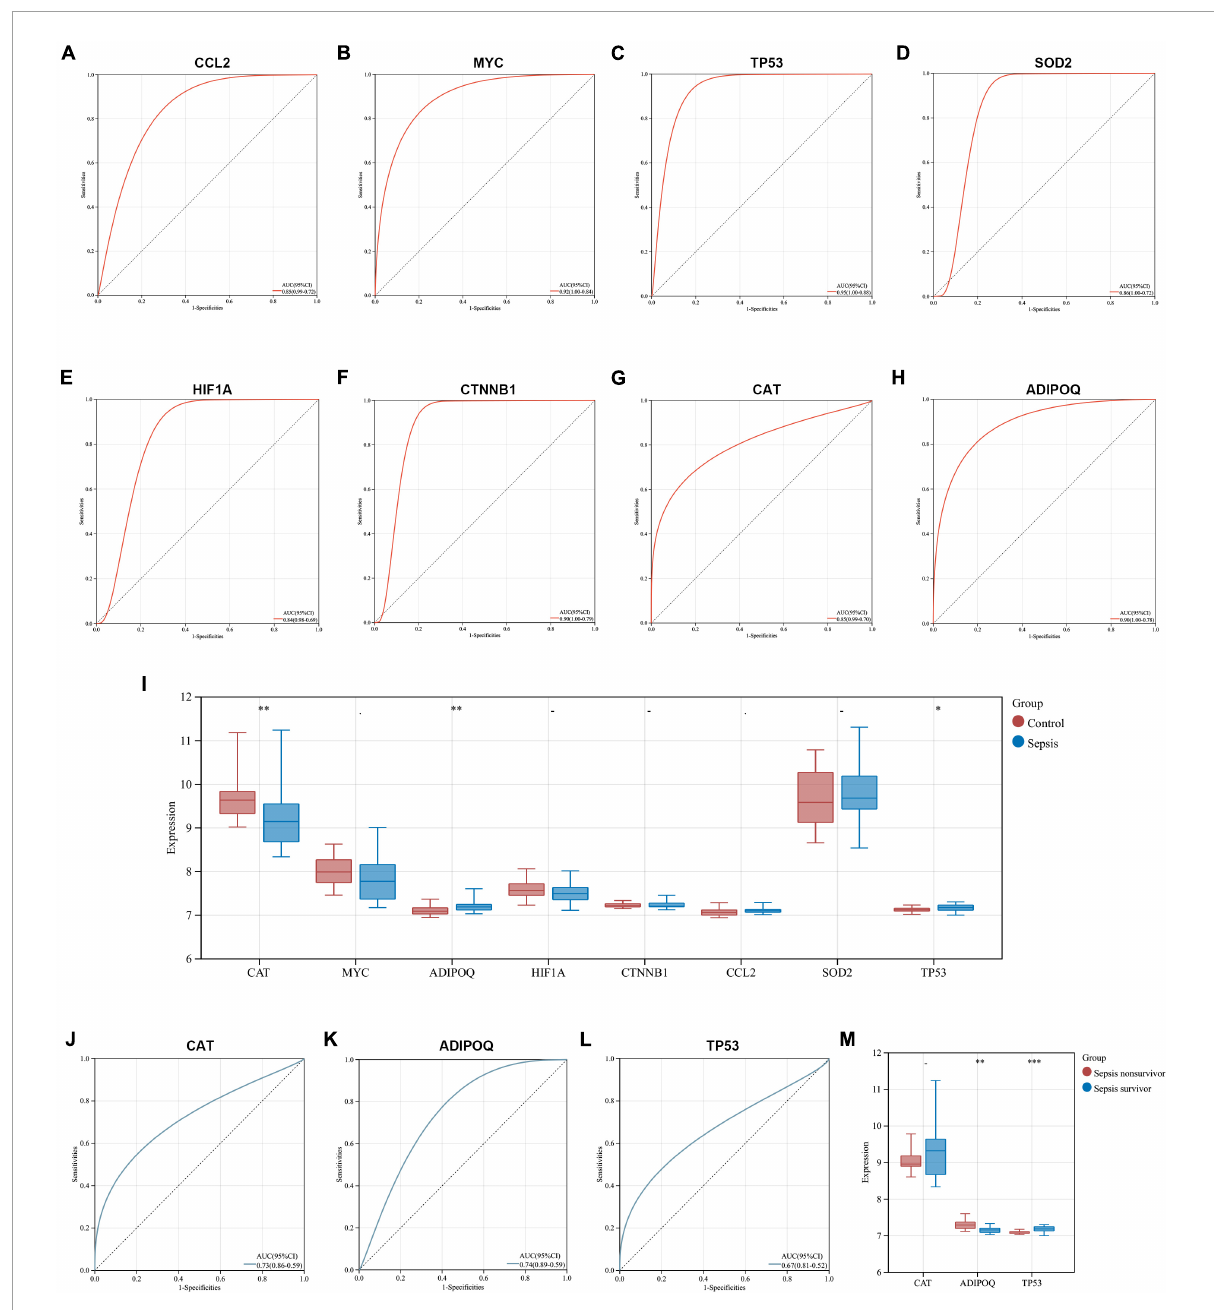
FIGURE8 Exploration of the diagnostic capability and prognostic relevance of key genes. (A–H) ROC curves show the diagnostic capability of key genes for SCM in heart samples from GSE79962. (I) Comparison of key gene expression in whole blood samples from sepsis and healthy controls in GSE54514. (J–L) ROC curves show the diagnostic capability of CAT, ADIPOQ, and TP53 for sepsis in whole blood samples from GSE54514. (M) Comparison of CAT, ADIPOQ, and TP53 expression in whole blood samples from sepsis survivors and non-survivors in GSE54514. ROC, receiver operating characteristic; AUC, area under the ROC curve. ∗ p < 0.05, ∗∗ p < 0.01, ∗∗∗ p <